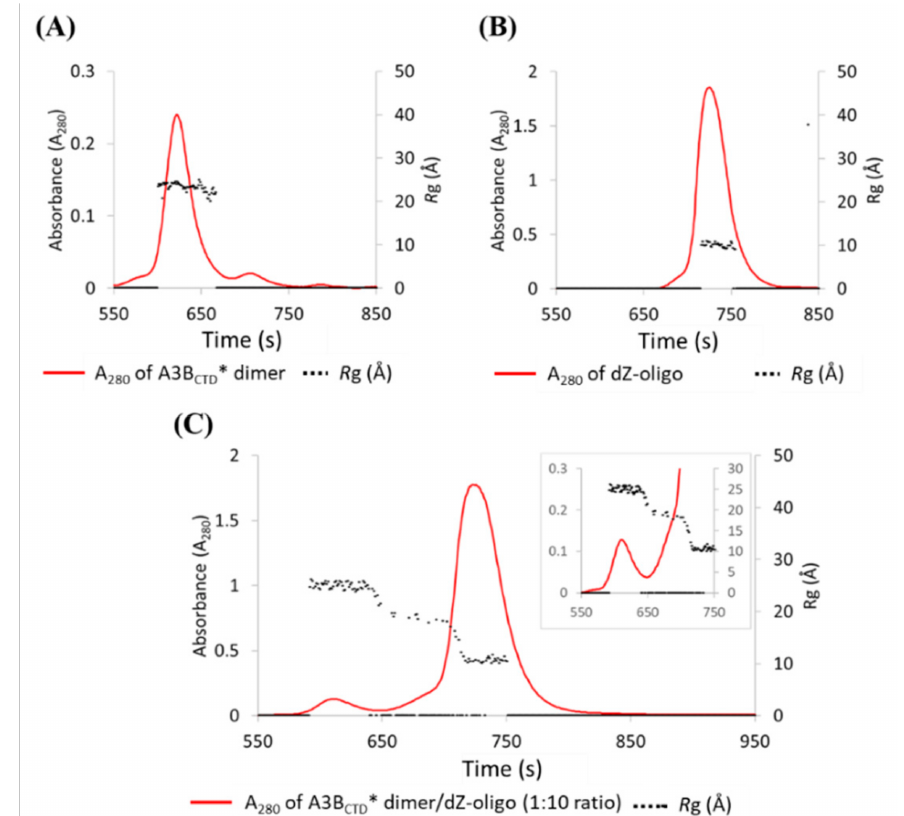
Figure 11. Size-exclusion chromatography (SEC) elution profiles of A3B CTD * dimer and A3B CTD * dimer/dZ-oligo. SEC- FPLC performed using ( A ) 2.5 mg/mL (~ 56 µ M) of A3B CTD * dimer, ( B ) 1.7 mg/mL (~566 µ M) of dZ-oligo, and ( C ) A3B CTD * dimer with dZ-oligo at a 1 to 10 ratio, closeup shown in the insert. Samples were run at 25 ◦ C through a SEC column at a flow rate of 0.2 mL/min in pH 5.5 buffer.